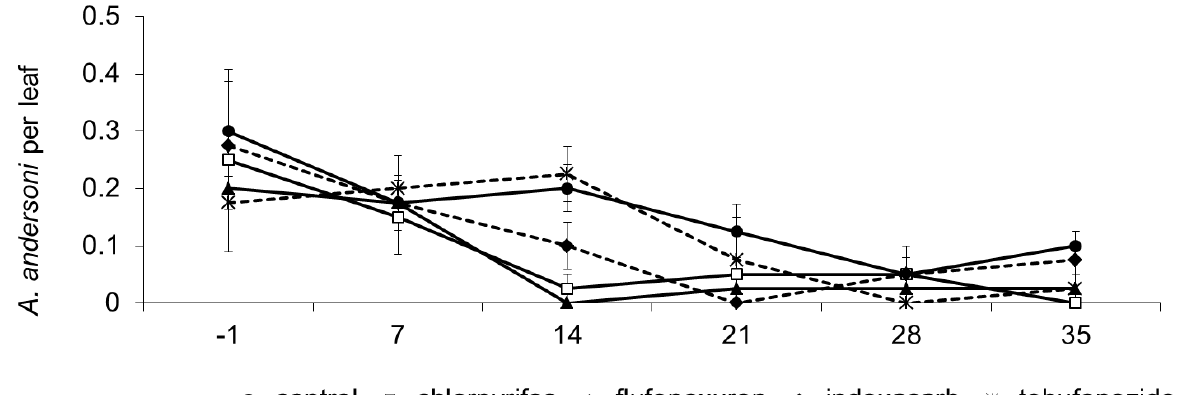
Figure 4. Population dynamics of Amblyseius andersoni (mean ± std. err.) observed in different treatments during experiment 4. On the X-axis, days after insecticide application are